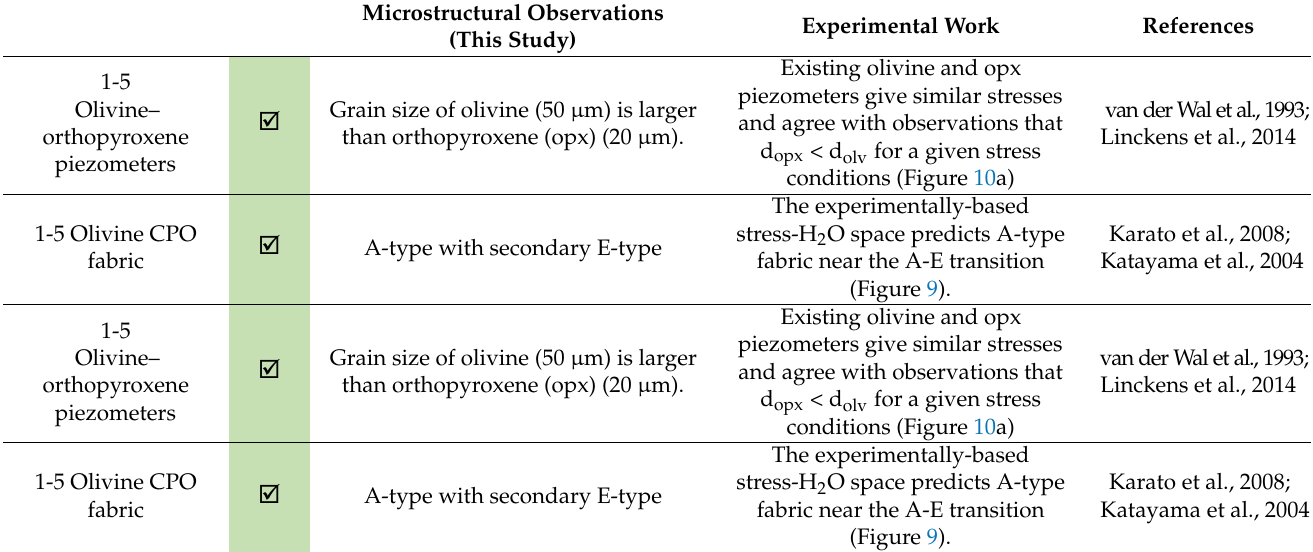
Figure 11. Strain rate vs. stress for olivine (red) and orthopyroxene (blue) for dislocation creep (solid lines) and diffusion creep (dashed lines). ( a ) Strain rates calculated for an assumed pre-deformation grain size (based on the size of porphyroclast grains) of 1 and 2 mm for olivine and orthopyroxene, respectively. The flow law parameters used are given in Table S1, Supplementary Materials. ( b ) Strain rates calculated for the recrystallized grain size of olivine and opx. ( c ) Expanded view of ( b ) for the range of conditions constrained from analysis of the kimberlitic sample; V * is the activation volume in units of (10 6 m 3 /mol). Table 1. Comparison between high strain rate sheared lherzolite and experimental observations.